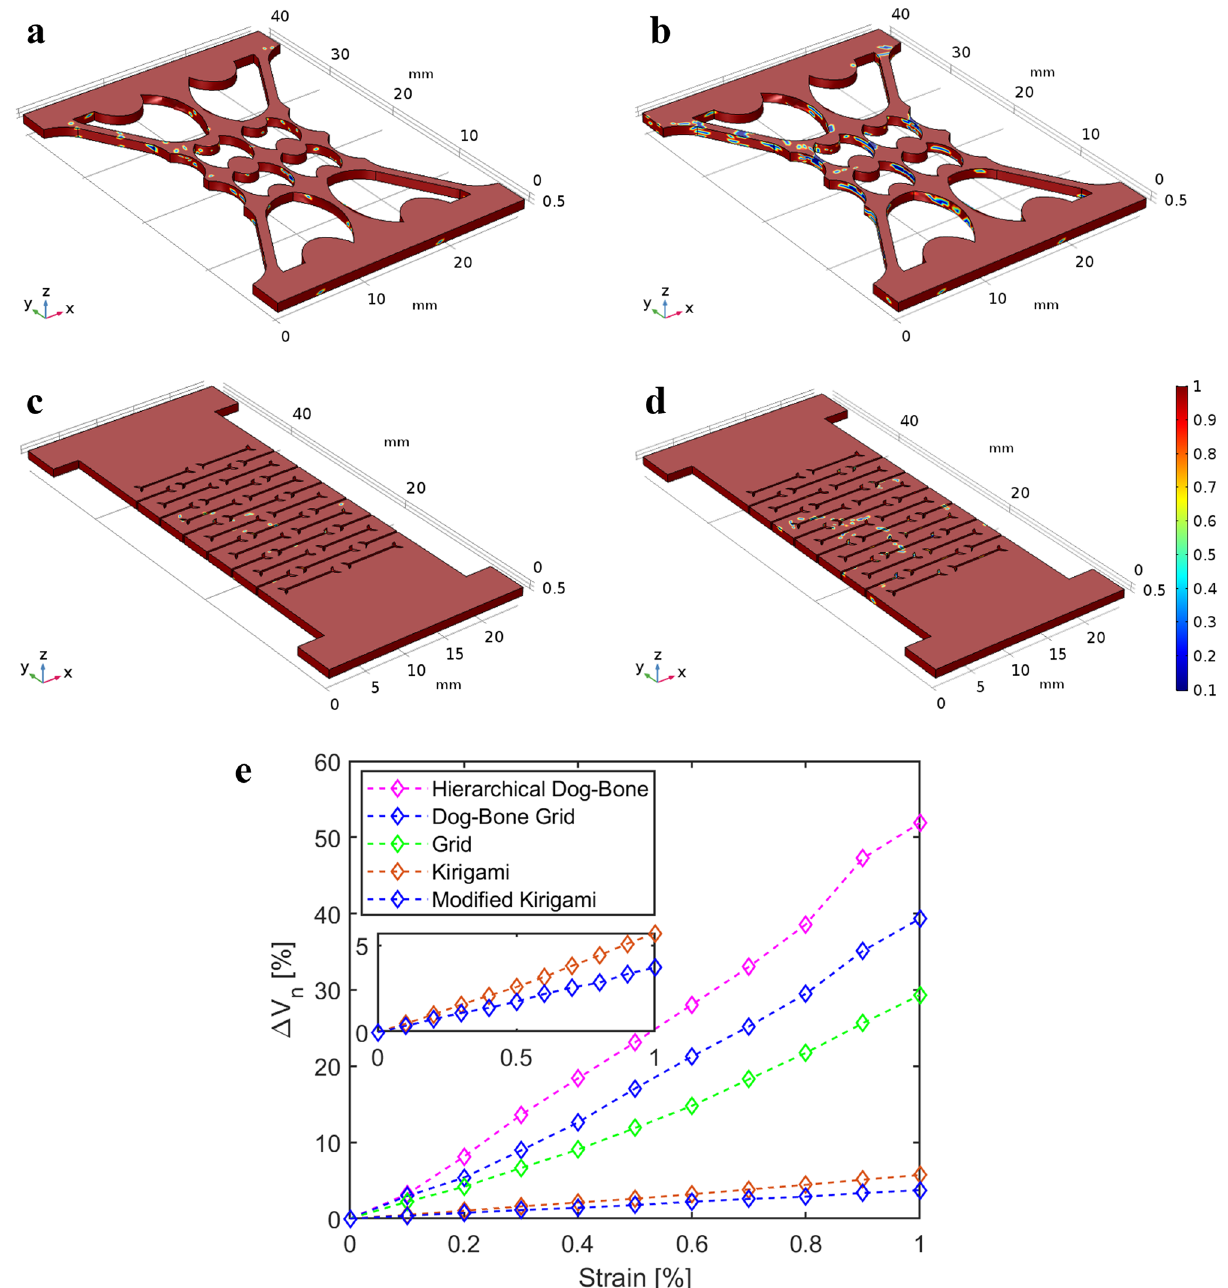
Figure 5. Simulated electromechanical response based on the percolated inhomogeneous material models. ( a , b ) Electrical conductivity distributions in the Hierarchical Dog-Bone Grid material model when it was subjected to 0.2% and 1% tensile strains along the y-axis, respectively. ( c , d ) Electrical conductivity distributions in the Modified Kirigami material model when it was subjected to 0.2% and 1% tensile strains along the y-axis, respectively. ( a – d ) Share the same color bar. ( e ) Simulated electromechanical responses of different topological material models when they were subjected to up to 1% tensile strain. The inset shows a zoomed-in view of the Kirigami-based material models’ electromechanical